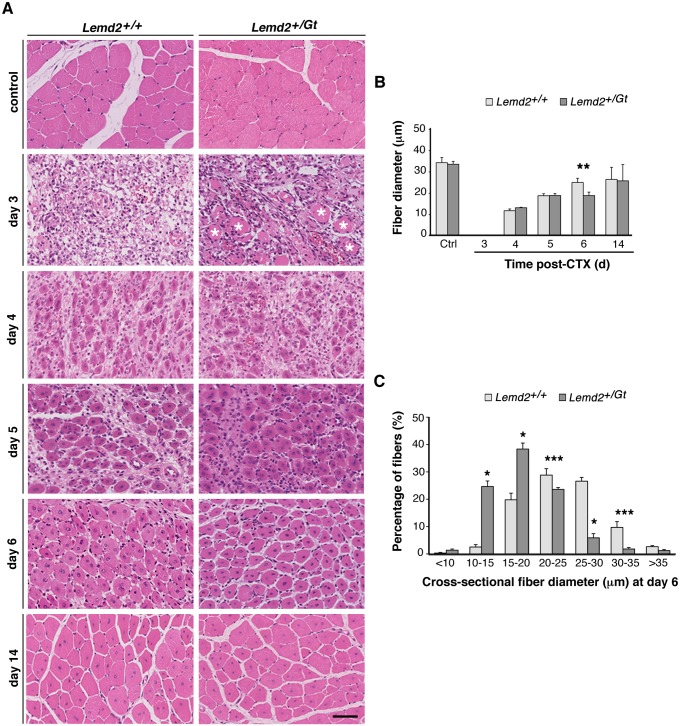
Muscle regeneration after cardiotoxin-induced injury in Lemd2
+/Gt mice.Muscle regeneration was induced by injection of CTX into the tibialis anterior (TA) muscles of 4-month-old mice. (A) H&E transverse sections of Lemd
+/+ and Lemd2
+/Gt TA control muscles, and TA muscles at days 3, 4, 5, 6, and 14 after CTX injury. * necrotic myofibers found in heterozygous TA samples 3 days post-CTX. (B) Mean myofiber diameter at days 3, 4, 5, 6, and 14 post-CTX injury. (C) Cross-sectional diameters of regenerated myofibers in wild-type and Lemd2
+/Gt TA muscle 6 days after CTX injury. Diameter of 100 myofibers with central nuclei were measured by ImageJ. Six samples of each genotype were analyzed. Data are presented as mean ± SD. (*p < 0.0005, **p < 0.005, ***p < 0.05, ns “not significant”).